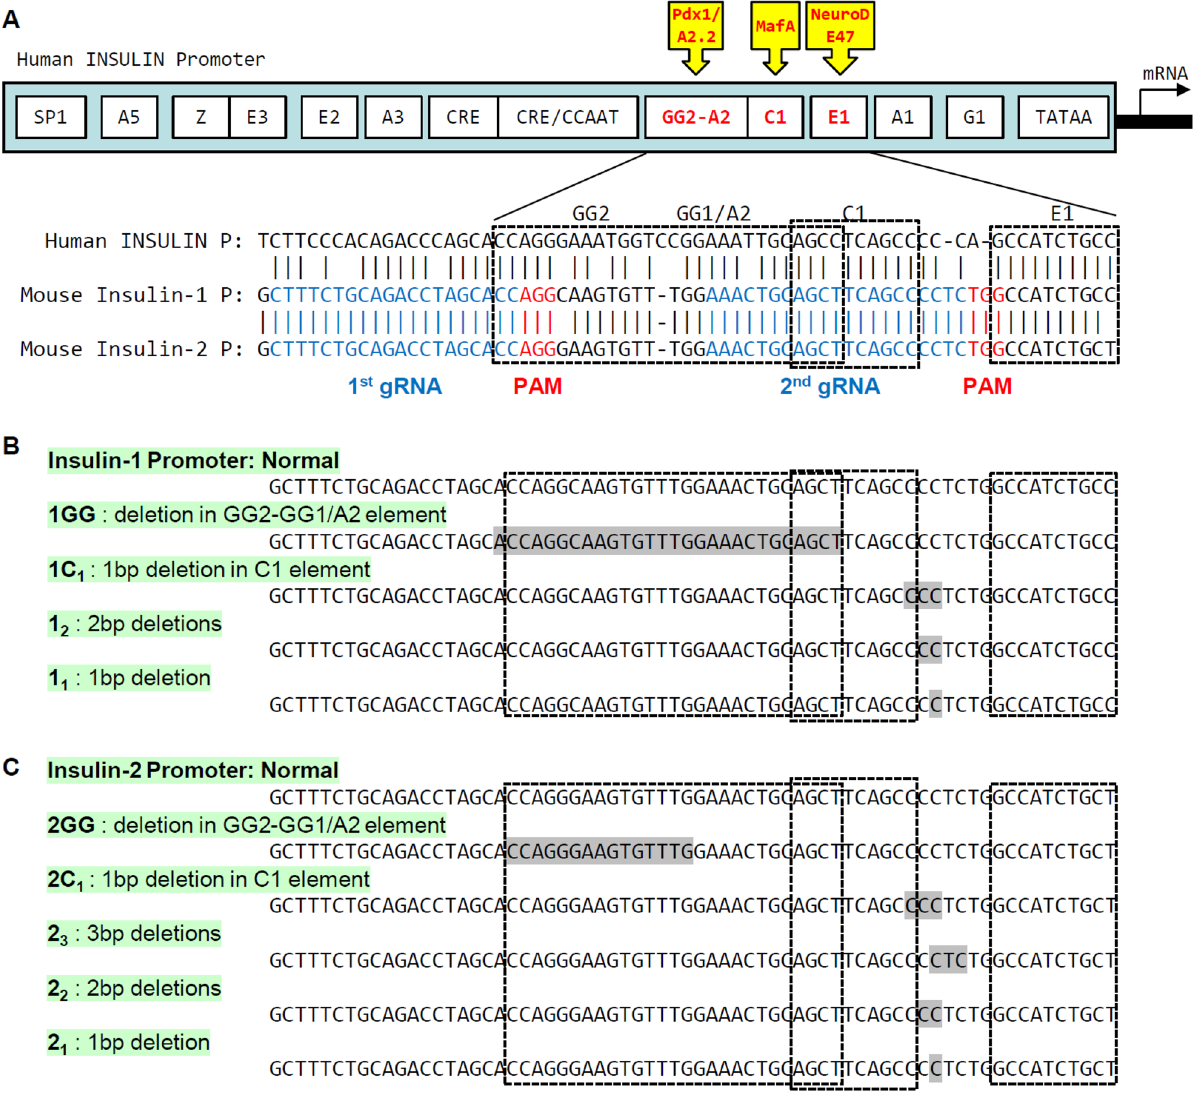
Figure 1. Generation of mice with mutations of the insulin promoter. ( A ) Structures and sequences of the human and mouse insulin promoters. Bases − 170 to − 147 and − 145 to − 104 of the mouse Ins1 and Ins2 promoters are identical, and bases − 149 to − 147 (AGG) and − 114 to − 112 (TGG) were used as the PAM sequences of the guide RNAs (gRNAs) for the CRISPR–Cas9 system. The 20-bp double-stranded DNAs (dsDNAs) derived from positions − 169 to − 150 and − 134 to − 115 of the Ins1/2 promoters were inserted into pX330. ( B , C ) Generation of mice with mutated insulin promoters. The mice with 4 types of deletions in the Ins1 promoter ( B ) and 5 types of deletions in the Ins2 promoter ( C ) were generated. Sequences shaded in gray were